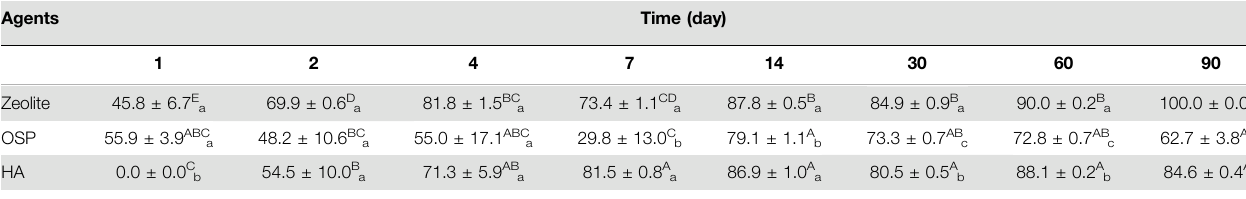
TABLE 8 | | The removal ef fi ciency (%) of 1000 μ g/L of LMG in seawater treated with three agents (200 mg/L) at observation point during 90 days. Agents